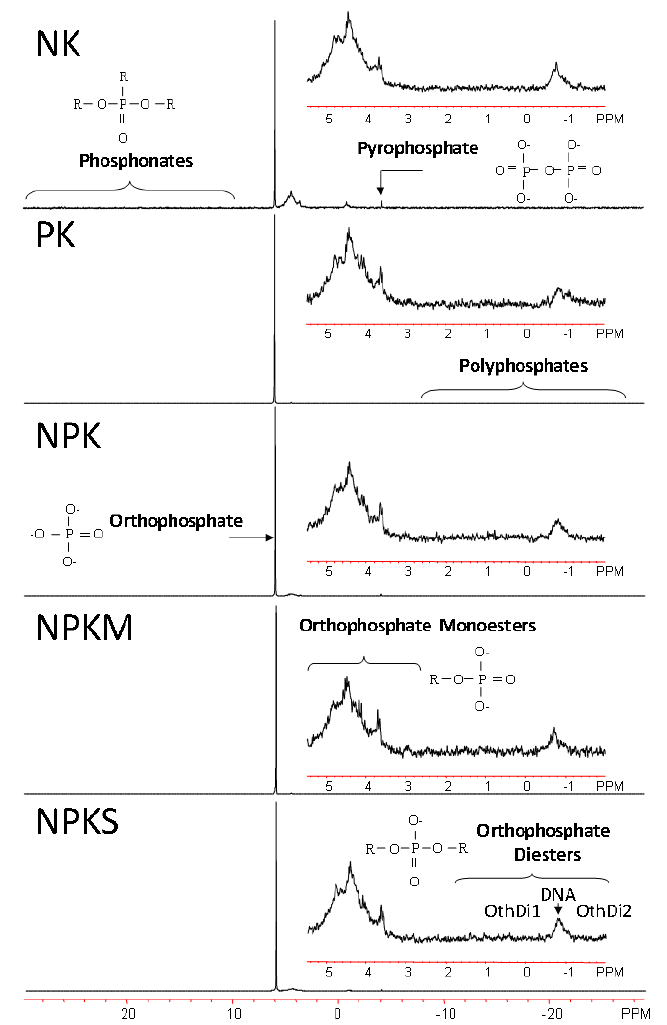
Figure 2. Solution P-NMR spectra of the investigated soils under different fertilization treatments.